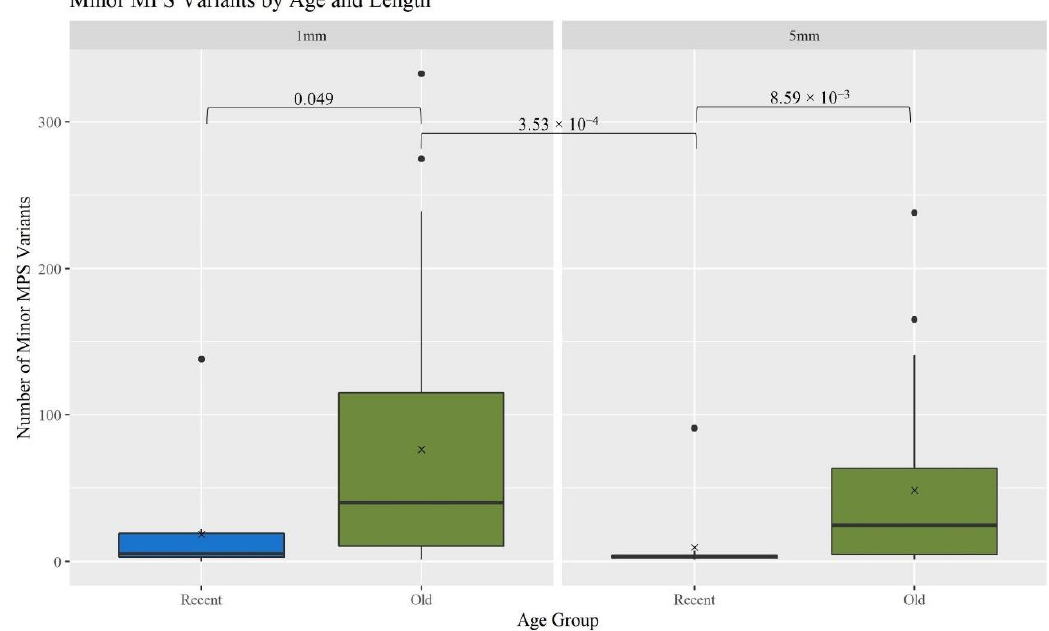
Figure 4. Boxplots for the comparison of the number of reported minor MPS variants for each age group and length (n = 74; n R = 26, n O = 48). The ‘x’ on the boxplots represents the mean and the line represents the median. Brackets show comparisons with significant p -values ( p < 0.05).